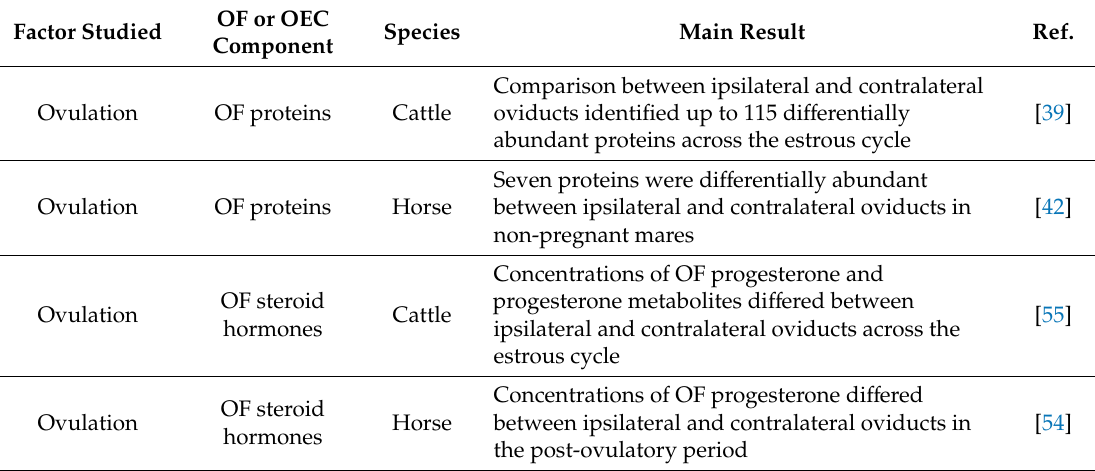
Table 1. Summary of factors regulating oviductal secretions in vivo. OF, oviductal fluid; OEC, oviductal epithelial cell; DEGs, di ff erentially expressed genes; TICAM2, Toll-like receptor adaptor molecule 2; hCG, human chorionic gonadotropin; eCG, equine CG; FSH, follicle stimulating hormone; EP2,4, prostaglandin E2 receptor 2,4; AGTR2, angiotensin II receptor type 2; PGR, progesterone receptor; ESR1, estrogen receptor 1; VEGF, vascular endothelial growth factor; FLT1, vascular endothelial